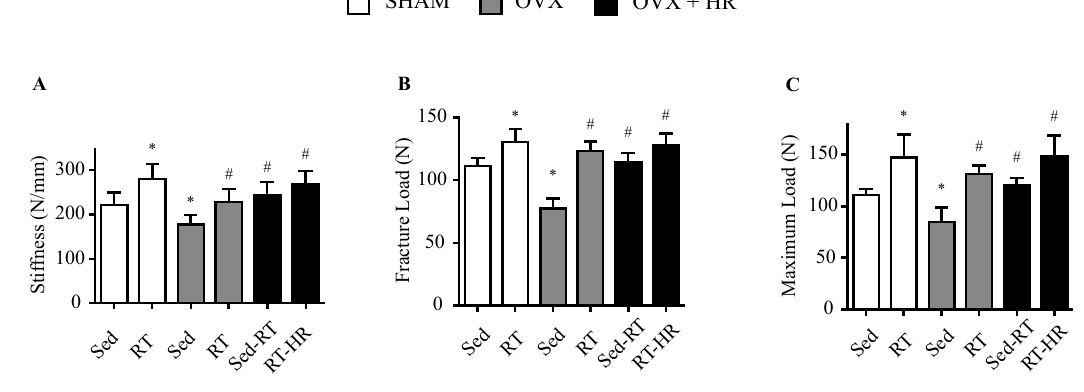
FIGURE 3: Biomechanical analysis of the left tibia: A) Stiffness (N/mm), B) fracture load (N), and C) maximum load (N). Values are presented as mean ± standard deviation of mean (SDM), P < 0.05. *Statistical difference compared to group SHAM Sed; #Statistical difference compared to group OVX